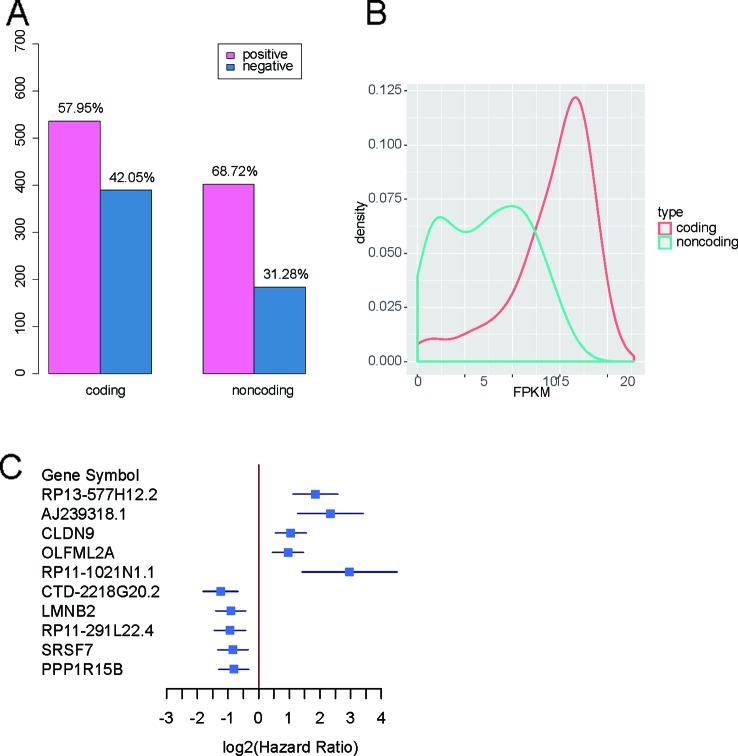
Overview of the prognostic protein-coding genes (PCGs) and long noncoding RNAs (lncRNAs). (A) Proportions of prognostic PCGs and lncRNAs positively and negatively correlated with death rates. (B) Distribution of expression levels for the PCGs and lncRNAs. (C) Forest plot for the top five genes positively and negatively correlated with death rates.